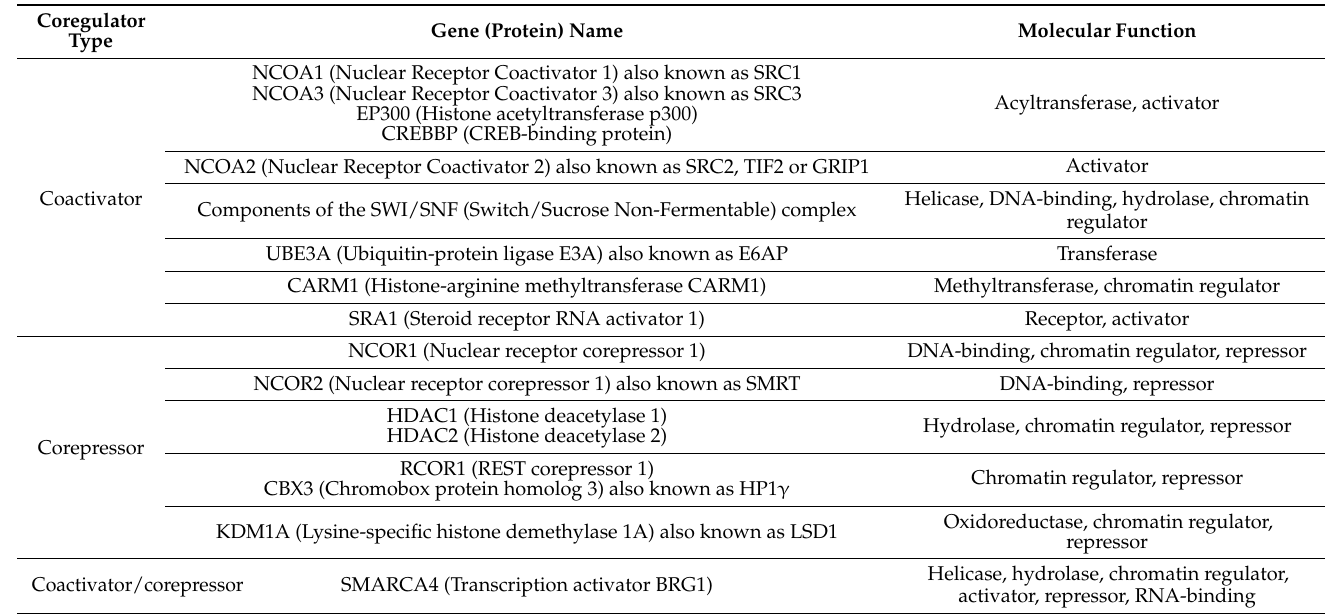
Table 1. Coregulators of PR transcriptional action [30,84]. Molecular function of the proteins as stated in the UniProt online database https://www.uniprot.org/ [91]. Depending on the molecular context the BRG1 protein can act as a coactivator (for example serving as a component of the SWI/SNF complex) or as a corepressor